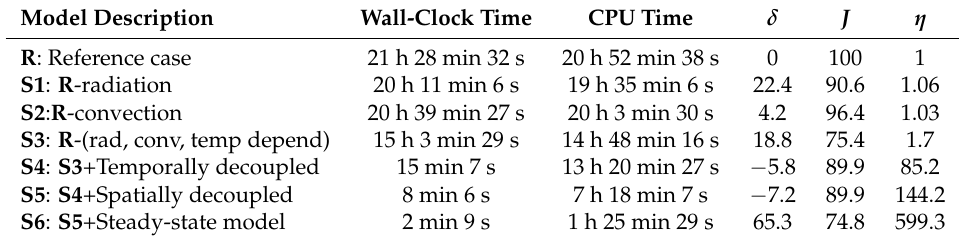
Figure 13. ( a ) Comparison metrics δ and J for judging the accuracy of the simplifications from the context of detecting heat accumulation. Low δ and high J implies higher conformance with the reference case. ( b ) Computational gain factors η for the simplifications. Table 2. Comparison of maximum percentage error δ , Jaccard index J , simulation times and computational gains for all simplified models. All computations are performed using 20 cores on a HPC cluster.